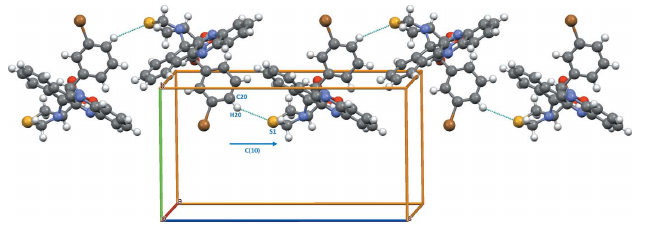
Figure 2 A C (10) chain motif formed through C—H (cid:3)(cid:3)(cid:3) S interactions extending along the c- axis direction. Hydrogen bonds are shown as dashed lines.